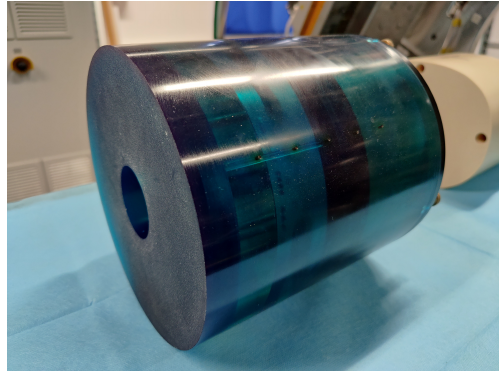
Figure 9. CATPHAN ®